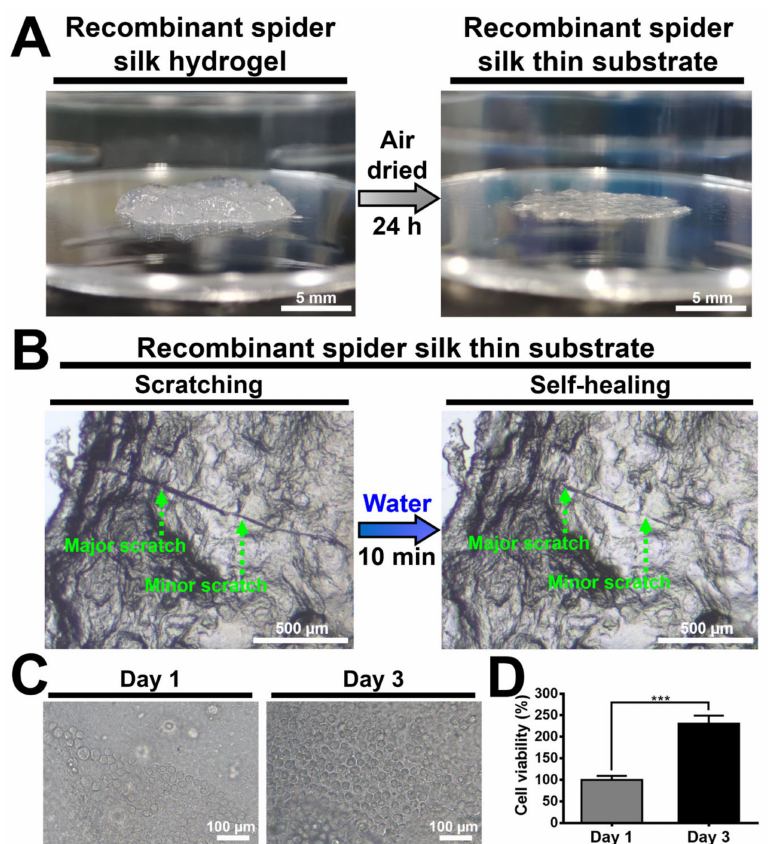
Figure 7. Fabrication, self-healing, and cytocompatibility of the recombinant spider-silk-coated films. ( A ) Images showing the recombinant spider silk fabricated from casting the recombinant spider silk hydrogel under ambient air and drying for 24 h at 25 ◦ C. The thickness of the film was ~200 µ m. ( B ) Optical microscopic images showing the healing of scratches on the surface of the recombinant spider silk after immersion in water for 10 min and then drying in ambient air for 6 h at 25 ◦ C. The green dotted arrows show the major scratches and the minor scratches. The proliferation of neural stem cells (NSCs) on the recombinant spider silk substrate was evaluated by ( C ) observation under the optical microscope and ( D ) the Cell Counting Kit-8 (CCK-8) assay. The cell viability was deducted from that of the control group (same substrates but without cells) and normalized to the initial value (i.e., cell viability at 1 day serving as 100%). *** p < 0.001 between the indicated